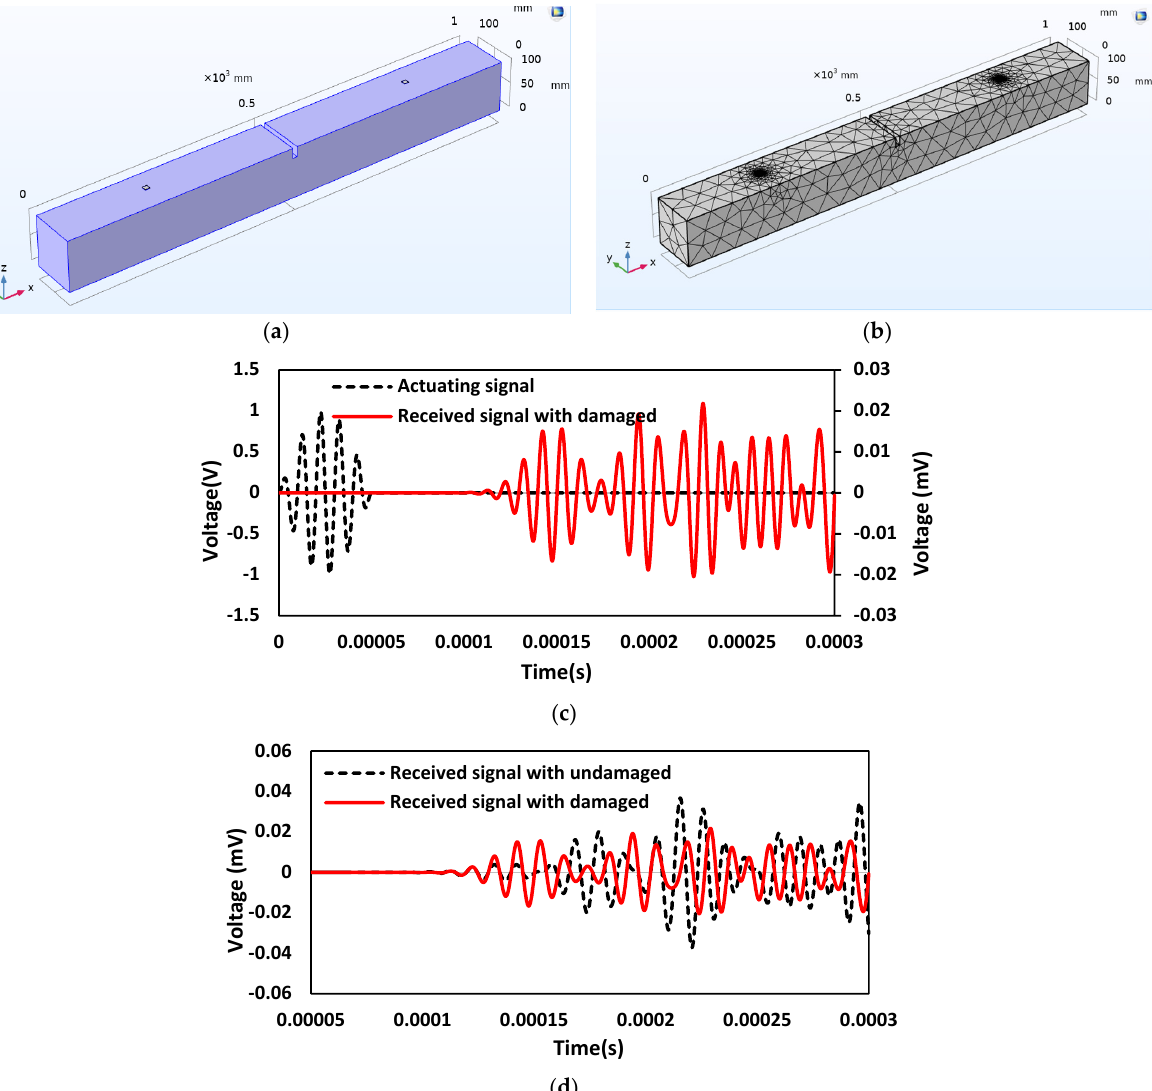
Figure 14. Damaged concrete beam with surface mounted PZT sensors: ( a ) Schematic 3D model; ( b ) FE model; ( c ) Response spectrum obtained from wave propagation measurements in the actuator– receiver mode; ( d ) Comparison of received signal between the damaged and undamaged concrete beam with the applied actuation signal.